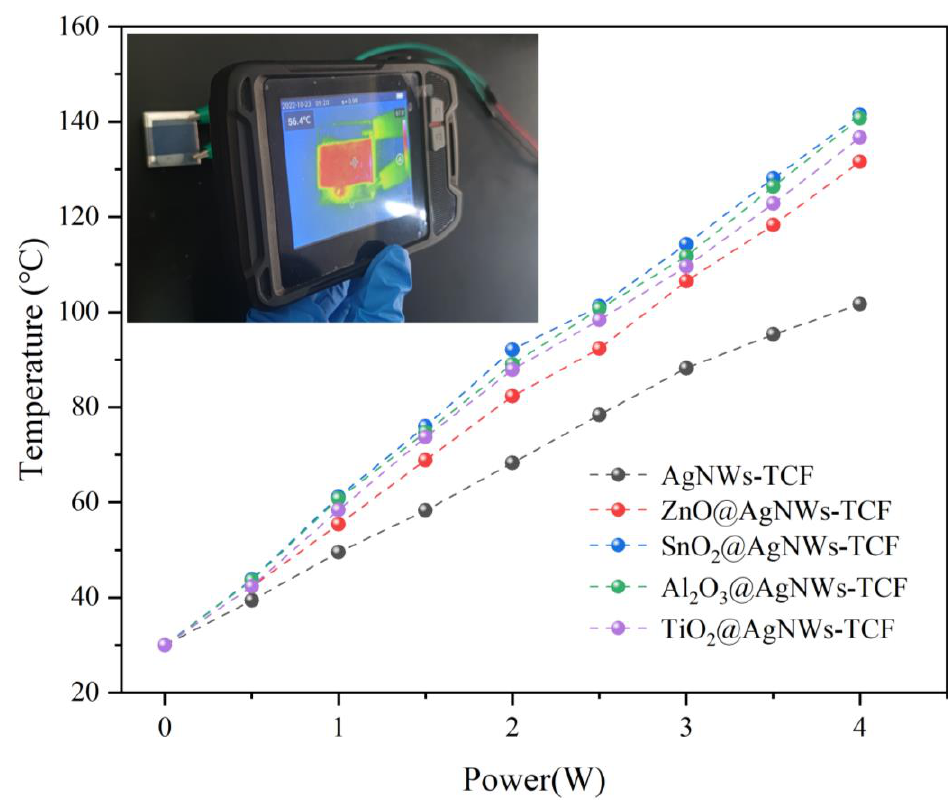
Figure 6. Relationship between electric power and temperature.